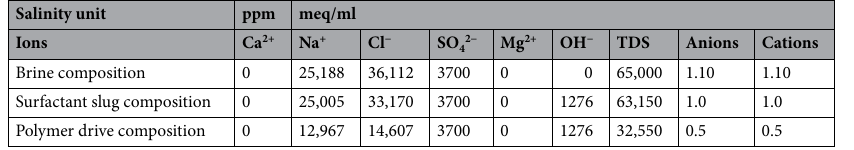
Table 8. Compositions of different waters used for two-phase dynamic surfactant retention experiment (A-5) of Wang 31 .